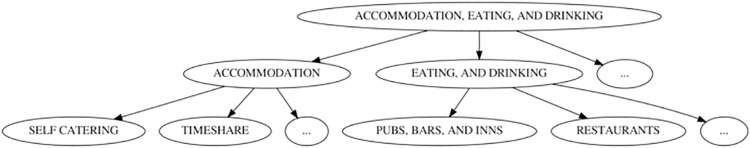
Subset of point of interest hierarchy.